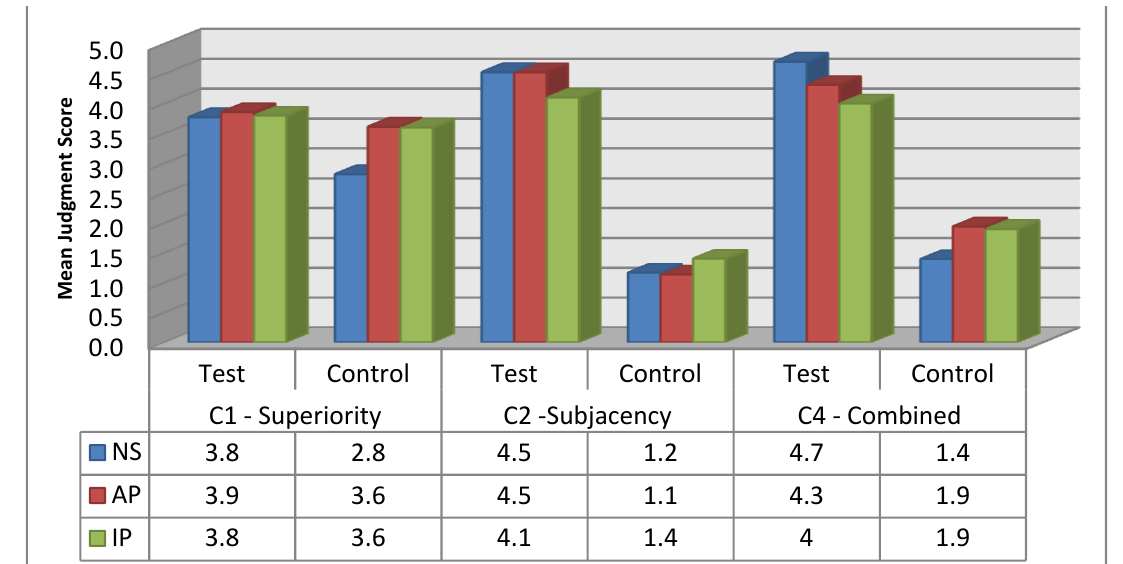
Figure 2. Mean grammaticality judgment scores for all three participant groups, NS (Native English), AP (L2 Advanced Proficiency), and IP (L2 Intermediate Proficiency), in ungrammatical test sentences vs. grammatical control sentences.